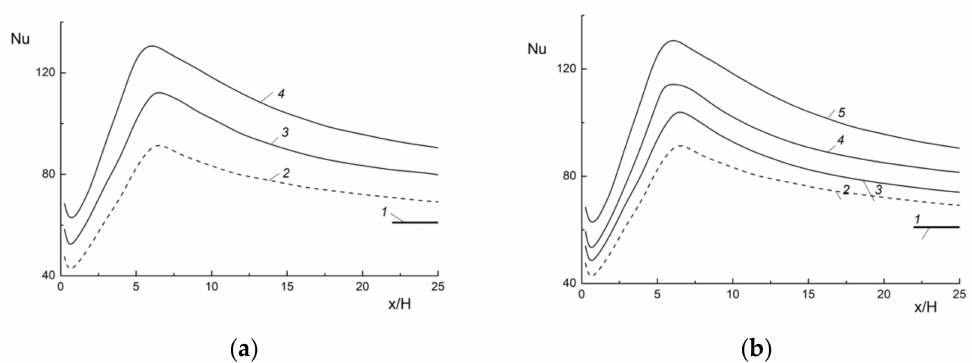
Figure 14. Heat transfer in the bubbly flow behind the backward-facing step along the streamwise coordinate. ( a ): d 1 = 3 mm, 1—Nusslet number value in the fully developed single-phase duct flow, 2— β = 0 (single-phase fluid flow, other conditions being identical), 3—2%, 4—5%; ( b ): β = 5%, 1—Nusslet number value in the fully developed single-phase duct